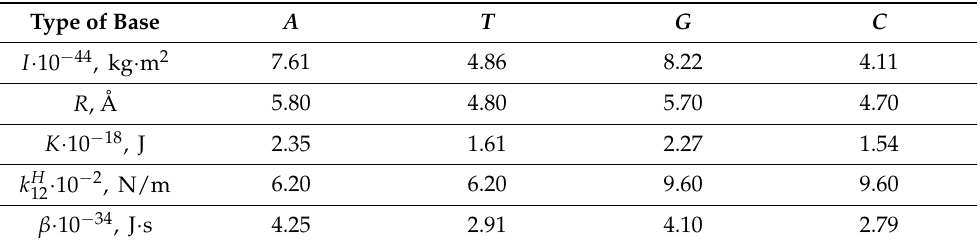
Table 1. Equation coefficients (1)–(6).